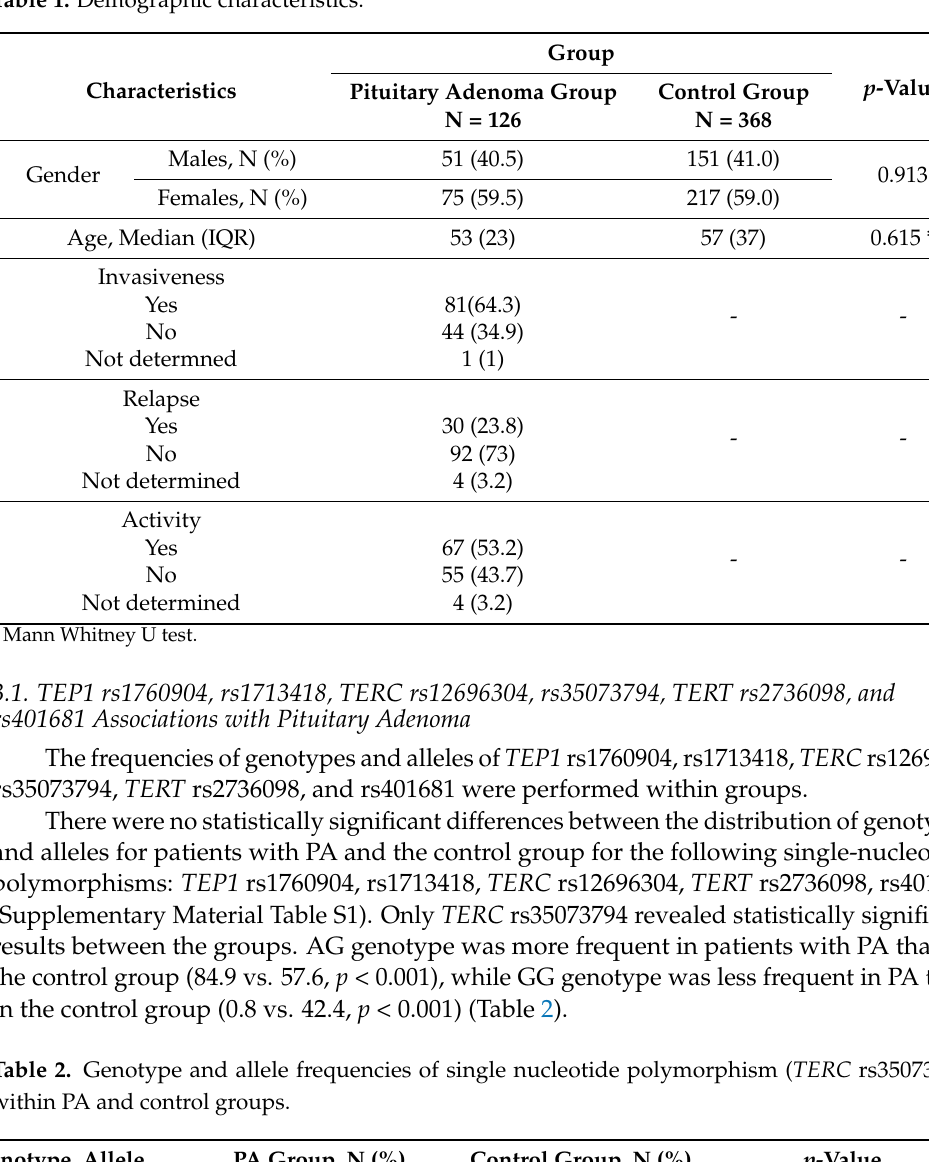
Table 1. Demographic characteristics.